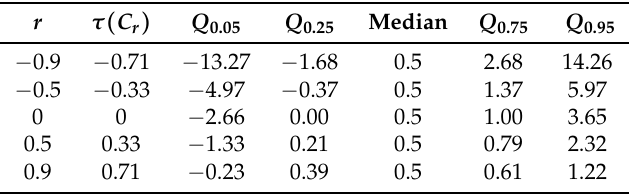
Table 2. Some percentiles of Z = X 1 / ( X 1 + X 2 ) , where ( X 1 , X 2 ) follows Gaussian